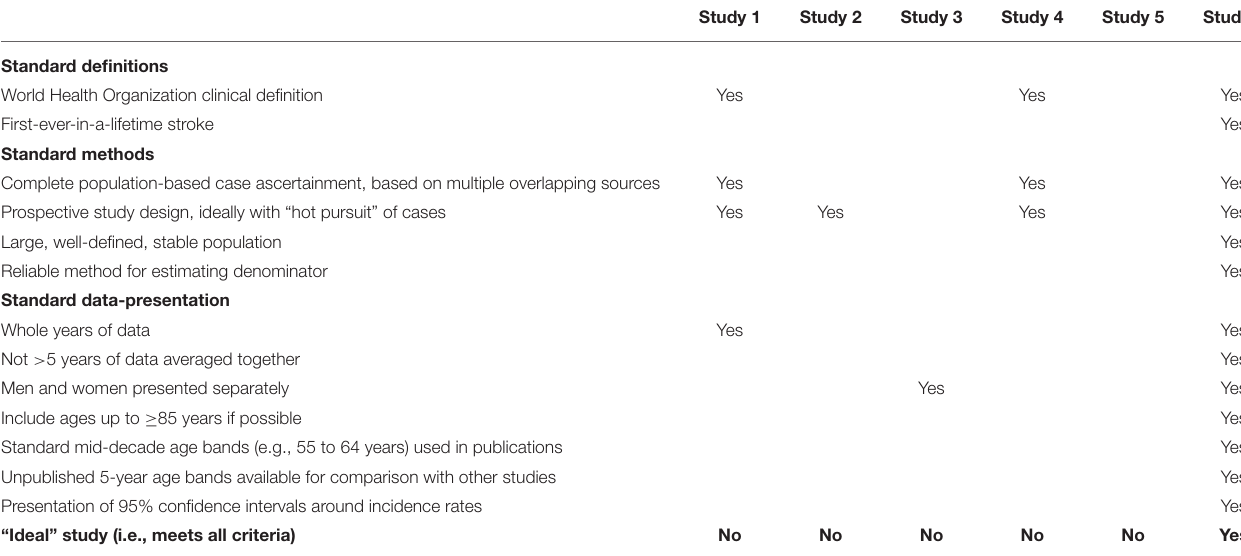
TABLE 3 | Criteria for Basic and Advanced Population-Based Stroke and TIA Incidence